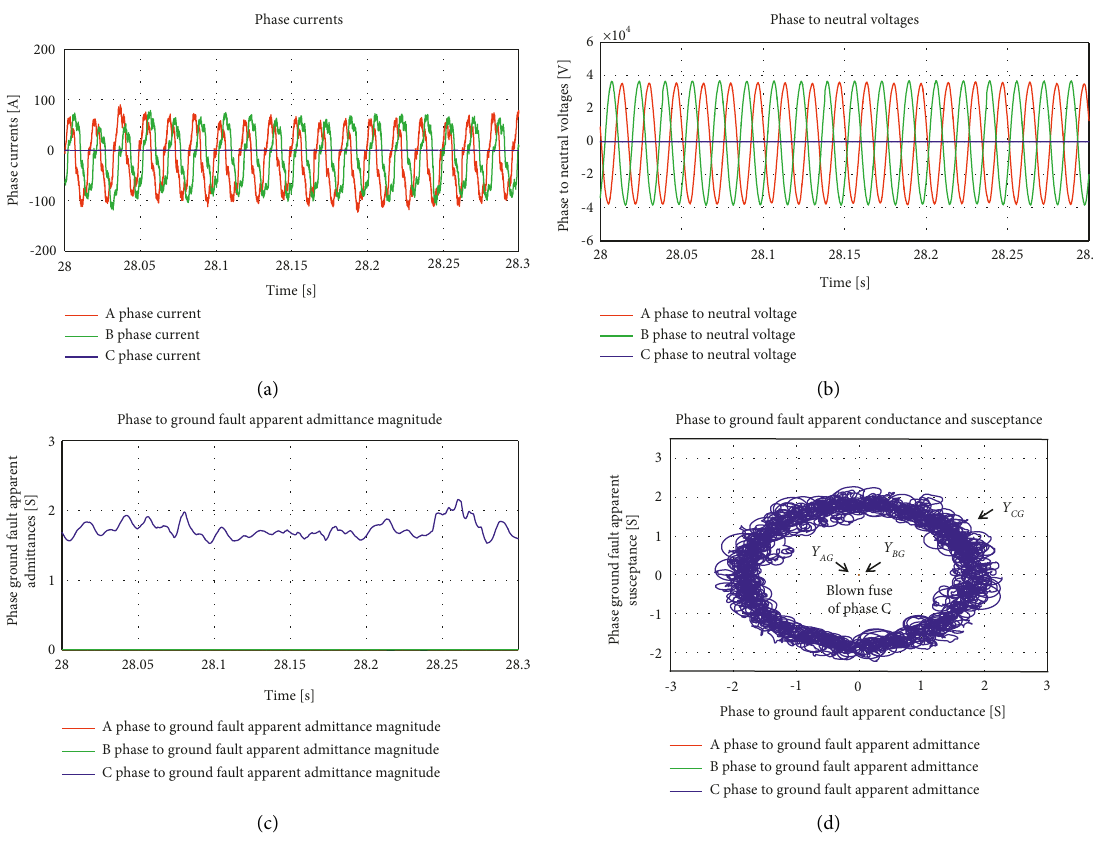
Figure 11: SIGID-932 event (a) currents, (b) voltages, (c) PGFA admittance magnitudes, and (d) PGFA conductance/susceptance from the optical power line sensors deployed on the